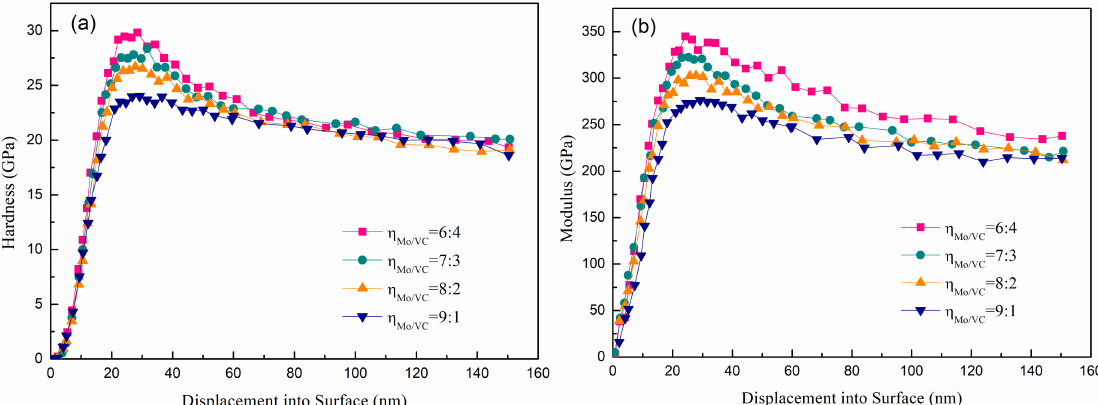
Figure 4. ( a ) Hardness and ( b ) Modulus of Mo/VC multilayers as a function of displacement onto the surface.